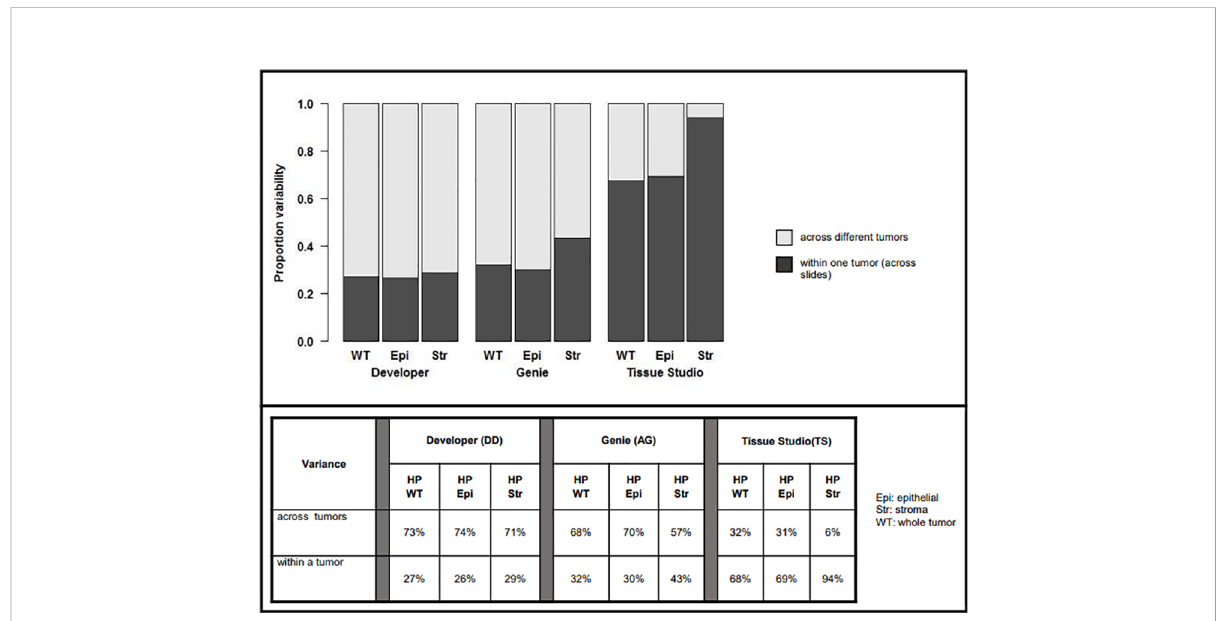
FIGURE 4 Variability in assessment of hypoxic percentage (in different tumor compartments) across platforms related to inter-patient (light gray) vs. intra- patient (dark grey)